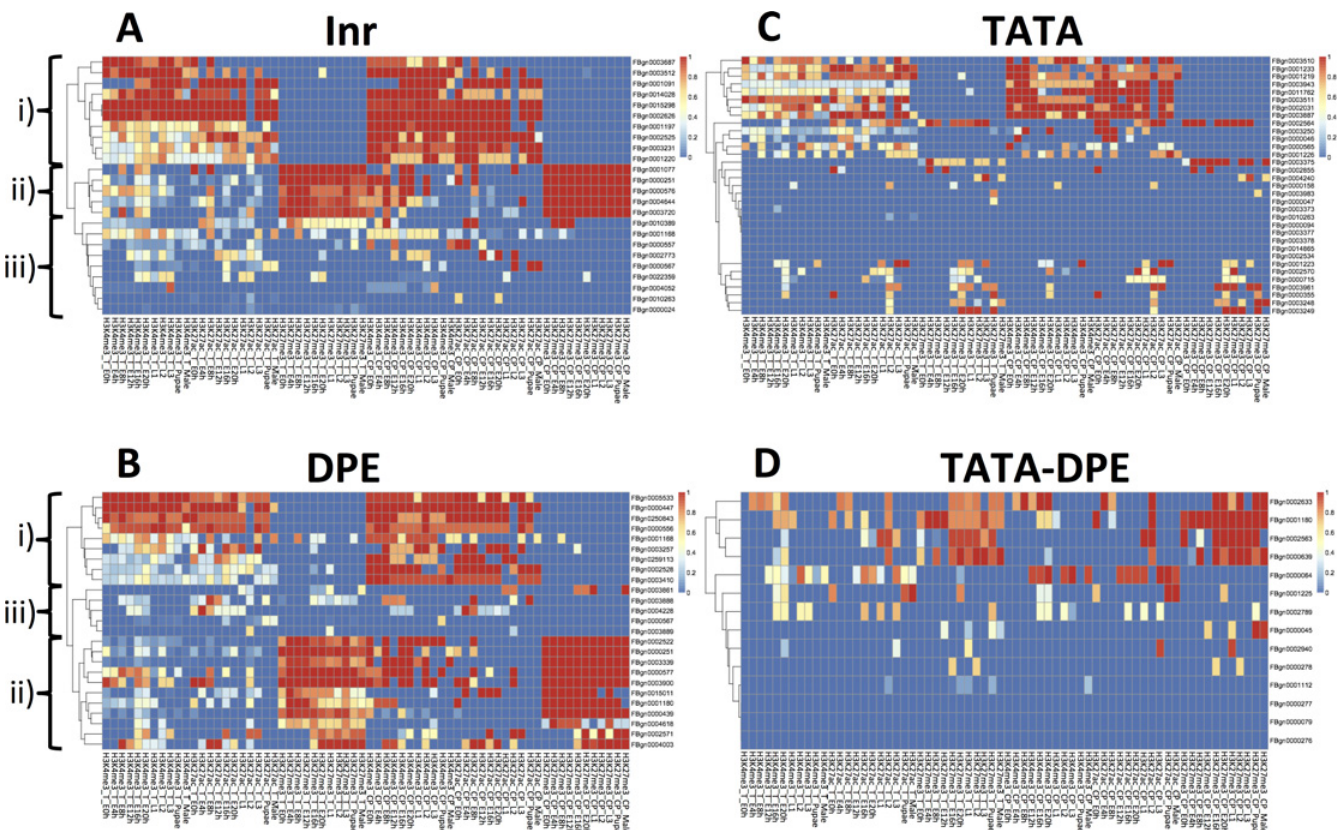
Fig 2. Histone modification dynamics in each CPE group. The y-axis represents genes to which the core promoters were assigned, and the x-axis represents histone modifications (H3K4me3, H3K27ac, and H3K27me3 from left to right for each histone modification) from embryos to adults. E0h: embryo at 0 – 4 h; E4h: embryo at 4 – 8 h; E8h: embryo at 8 – 12 h; E12h: embryo at 12 – 16 h; E16h: embryo at 16 – 20 h; E20h: embryo at 20 – 24 h; L1: larval stage 1; L2: larval stage 2; L3: larval stage 3; Pupae; Male: adult male. The order of genes reflects the results of hierarchical clustering using the pheatmap package in R. The warm color indicates that the histone modification ratio was high. (A) Heatmap of histone modification dynamics in Inr group (n = 24), (B) Heatmap of histone modification dynamics in DPE group (n = 25), (C) Heatmap of histone modification dynamics in TATA group (n = 33), (D) Heatmap of histone modification dynamics in TATA-DPE group (n =